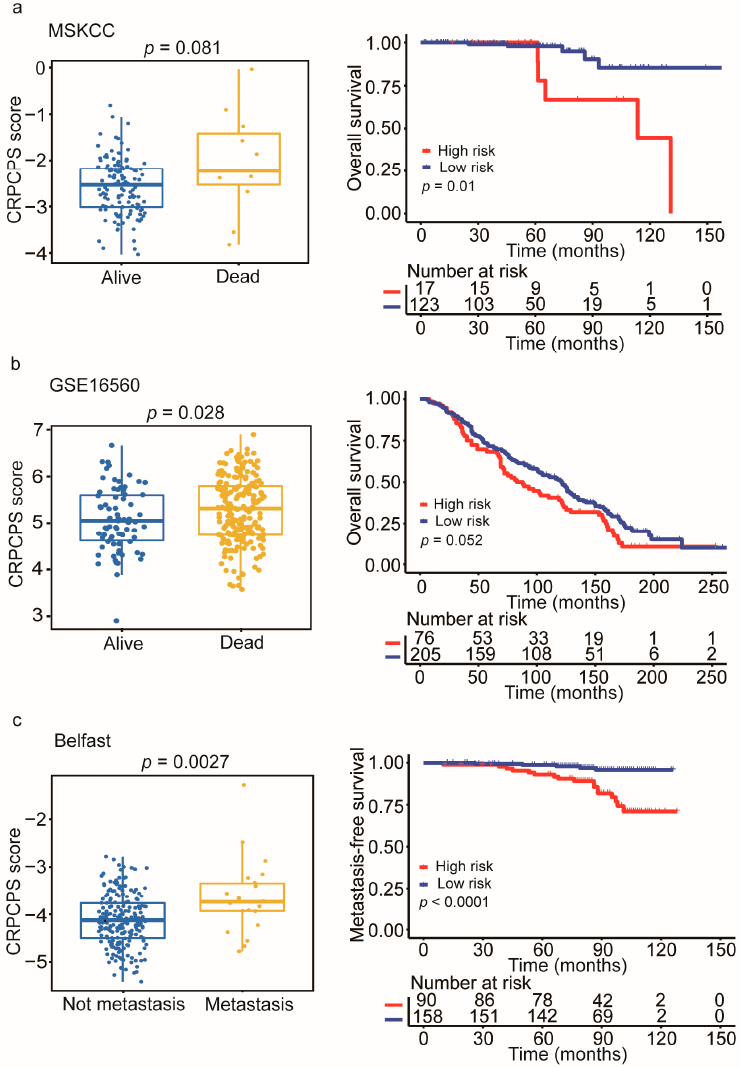
Figure 7. The association of CRPCPS with patients’ survival/metastatic status and CRPCPS’s performance in predicting overall survival (OS) and metastasis-free survival (MFS) in different patient cohorts. Association of CRPCPS with patients’ survival/metastatic status (left panel) and Kaplan–Meier plot (right panel) for predicting OS/MFS in the MSKCC cohort (left, n = 140) ( a ), the GSE16560 cohort (left, n = 281) ( b ), and the Belfast cohort (left, n = 248) ( c ). The differences between the two groups were determined by the log-rank